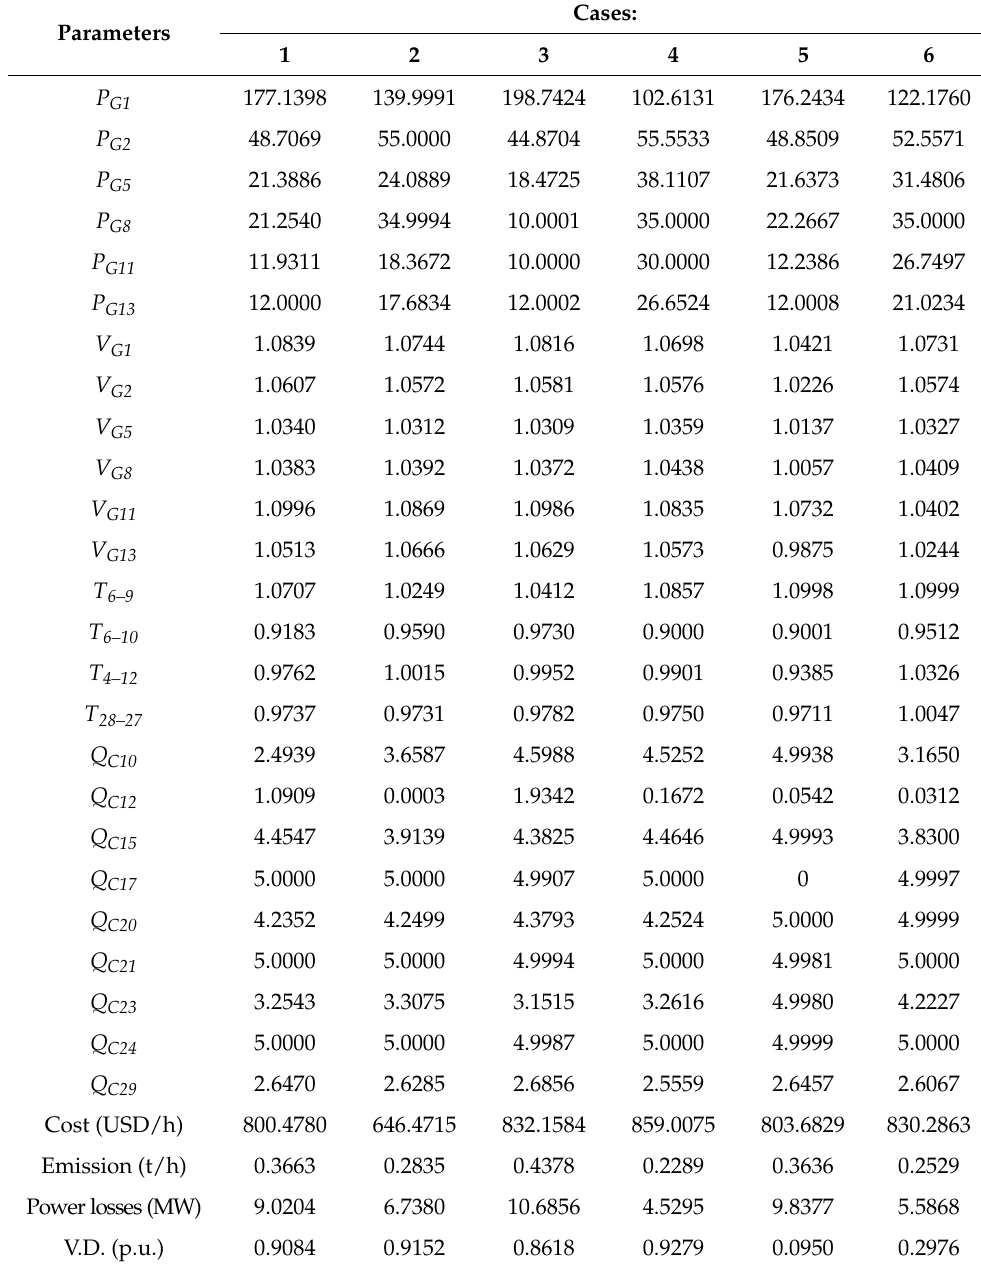
Table 3. Optimal values of the OPF problem variables without stochastic renewable energy, obtained by